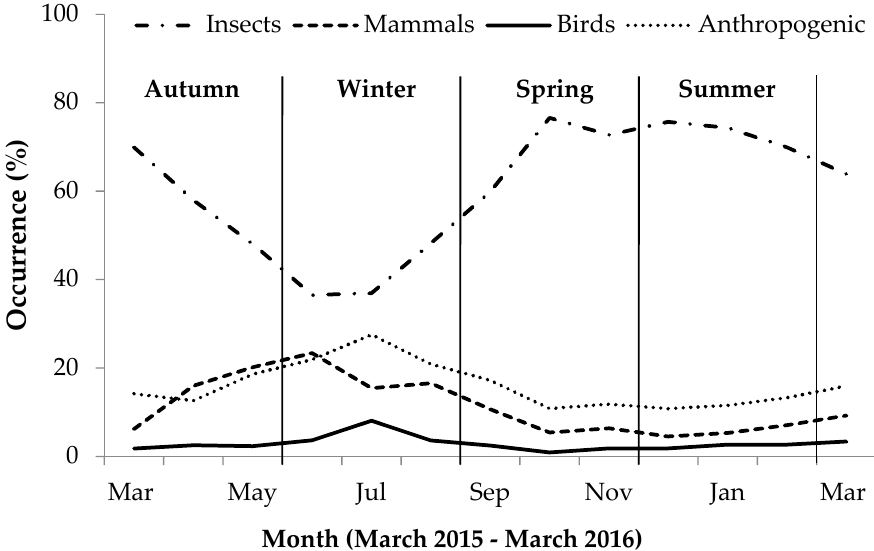
Figure 1. Monthly percent occurrence (%) expressing seasonal variation in occurrence of different food categories in yellow mongoose scat in the Meyersdal estate.